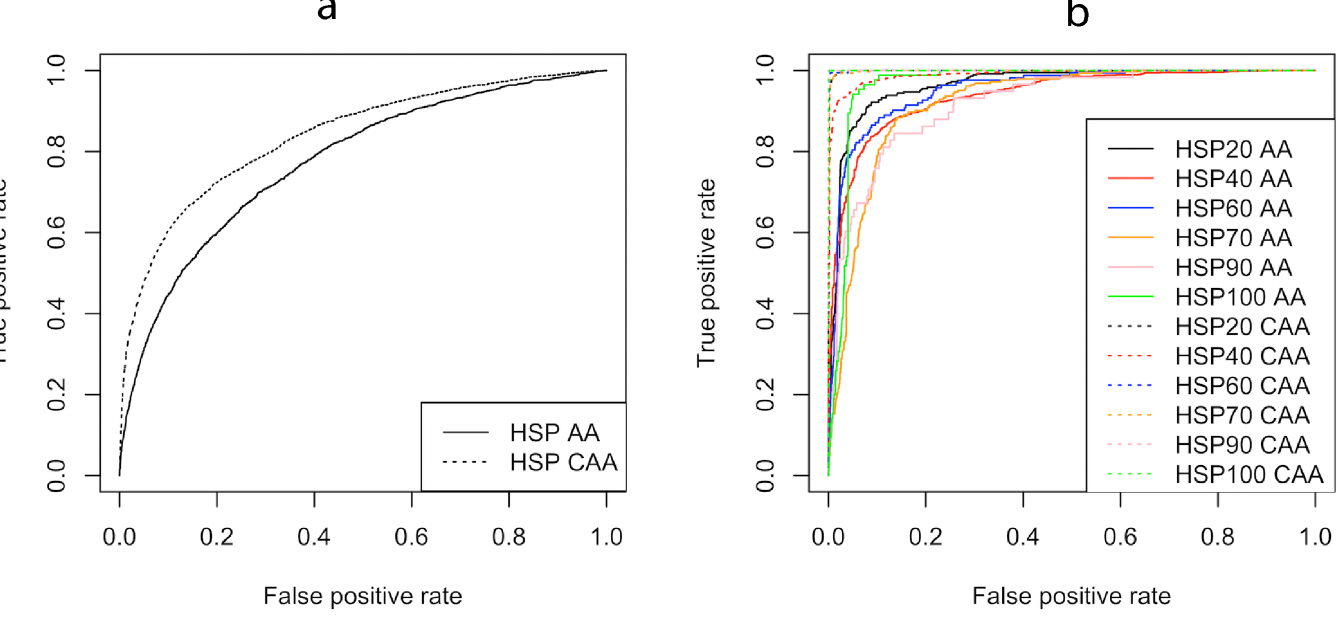
Fig 4. ROC curve of SVM models based on amino acid and coupled amino acid composition for prediction of (4a) HSPs and (4b) different families of HSPs. Solid line represents discrete amino acid composition (AA) while broken represents coupled amino acid composition (CAA) based SVM model.